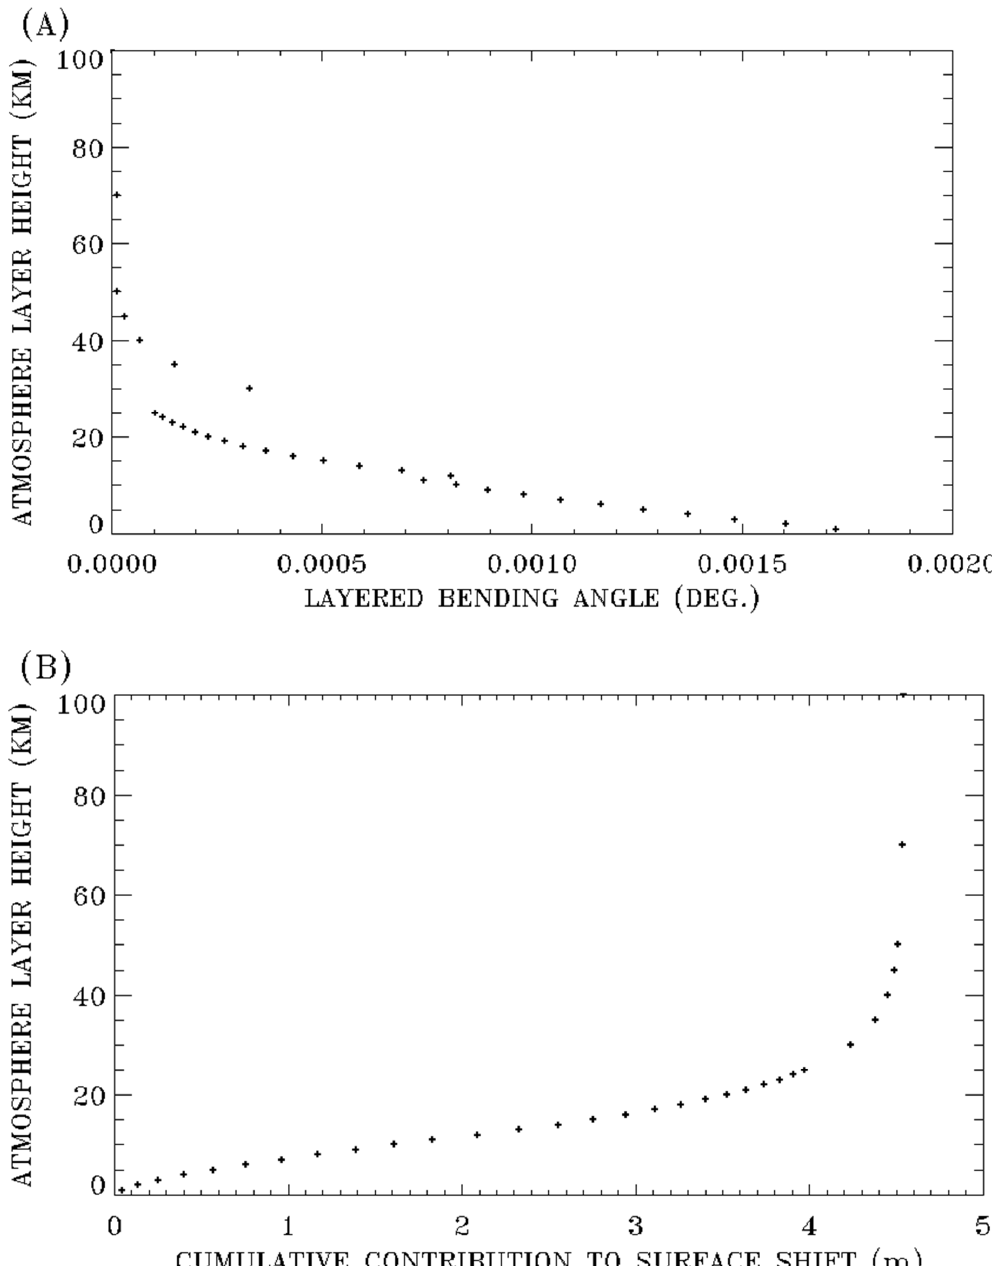
Figure 2. ( A ) Layer by layer atmospheric refractive bending angles and ( B ) cumulative pixel shift at the surface for green light (550 nm) for the US 1976 model atmosphere, a satellite altitude of 500 km, and a downward view zenith angle of 45 degrees.